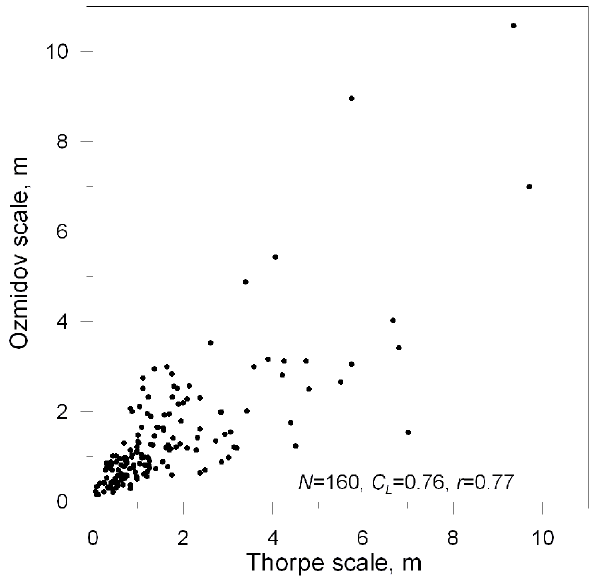
Fig. 9. Ozmidov scale versus Thorpe scale in the interfacial